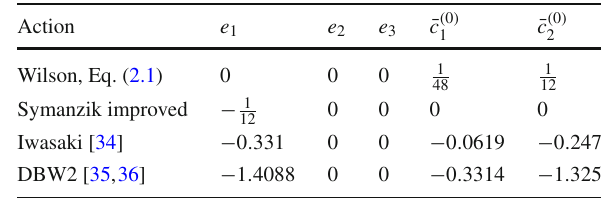
Table 1 Commonly used gauge actions and their coefficients of the operators